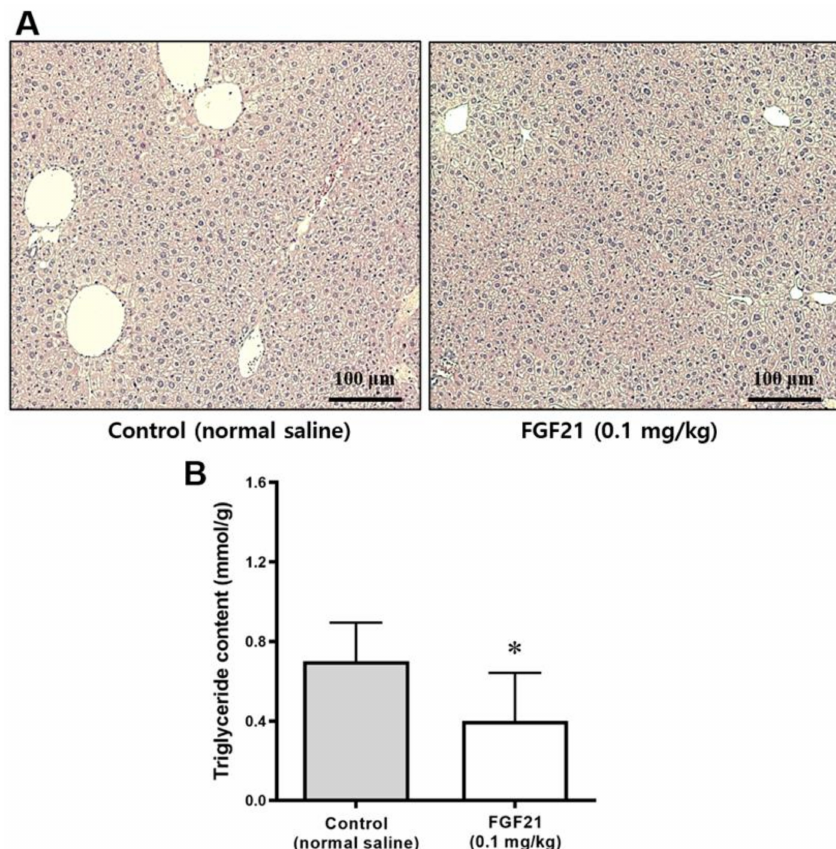
Figure 7. ( A ) Liver histology revealed by H&E staining. All images were acquired at magnification x 200 ( n = 10 in the control, n = 9 in the FGF21 group). ( B ) Triglyceride content in the liver (mmol / g). Data are means ± SD. * p < 0.05 vs.